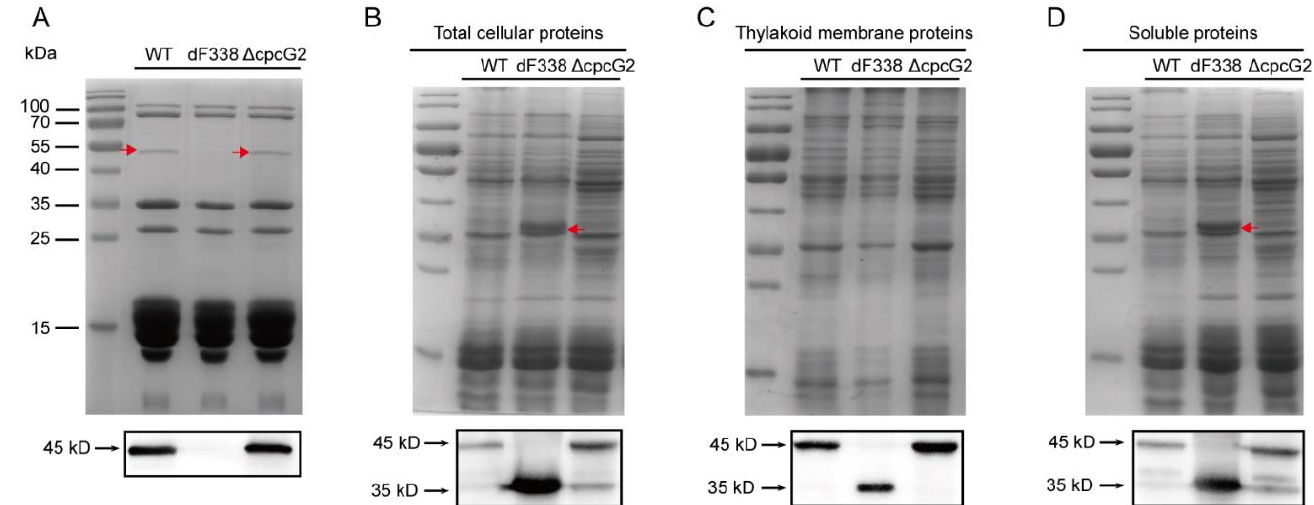
Figure 1. SDS-PAGE and immunoblotting analysis of ferredoxin:NADP + oxidoreductase (FNR) from different strains. ( A ) SDS-PAGE separation of phycobilisome (PBS) proteins from the wild-type (WT), dF338 and ΔCpcG2. Red arrows indicate FNR protein, which is missing in the dF338 mutant. The molecular mass markers are shown as bars on the left side. Proteins separated by SDS-PAGE were transferred from gel to nitrocellulose membrane for immunoblotting and a portion of the blot is shown in the box below the gel image. ( B – D ), total cellular proteins, thylakoid membrane proteins and soluble proteins were extracted and separated by SDS-PAGE respectively, from the strains WT, dF338 and ∆ CpcG2. The red arrows in panel ( B , D ) indicate an increased intensity of the protein bands at the position of approximately 35 kDa. Immunoblotting analysis of FNR proteins are shown in the boxes below each gel. The molecular masses of the immunoblotting bands are shown on the left of the boxes as indicated by black arrows.